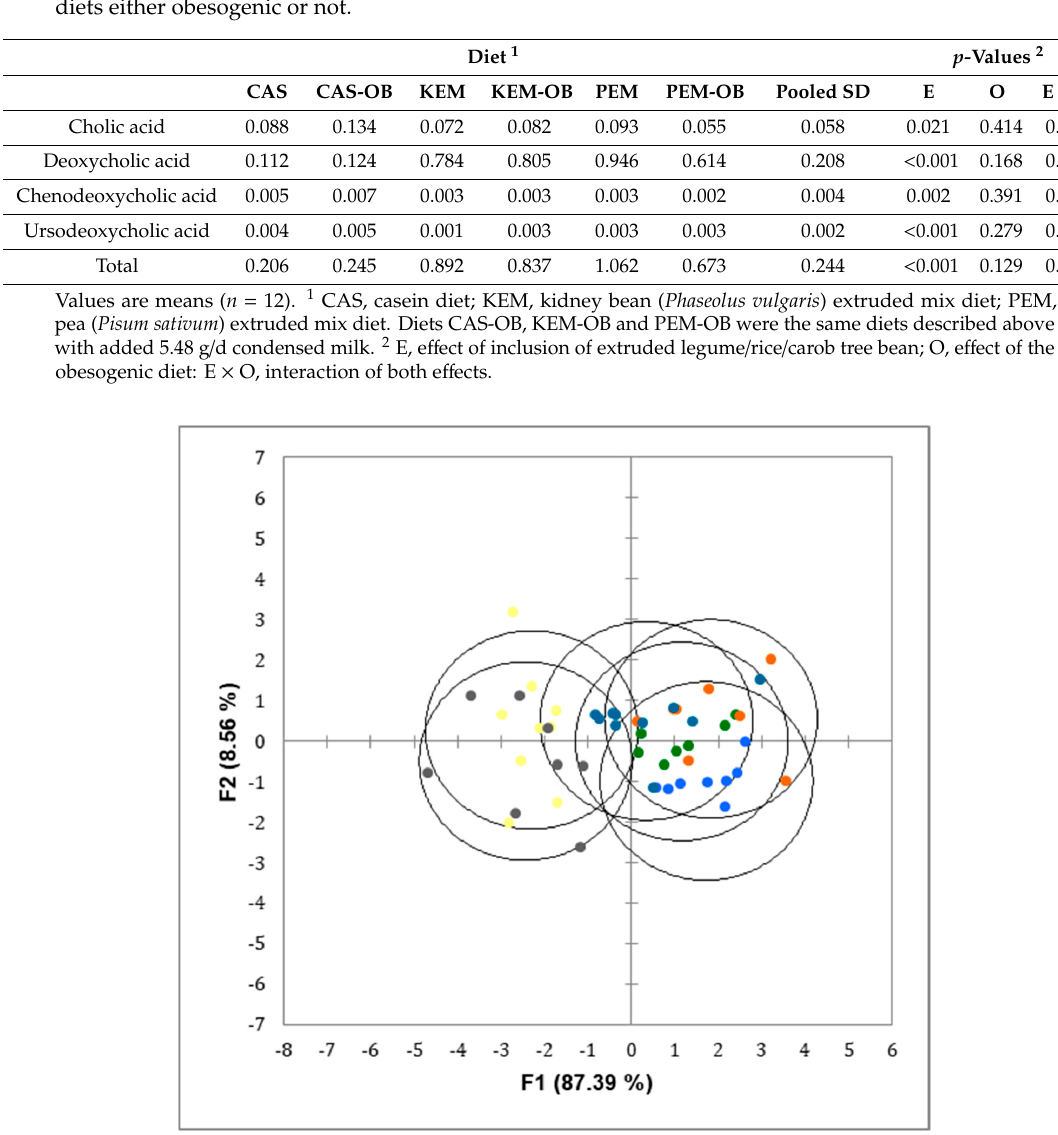
Figure 2. Discriminant analysis of the expression levels of bile acid concentration ( µ M / g) in the faeces of rats fed CAS (yellow); CAS-OB (grey); KEM (orange); KEM-OB (dark blue); PEM (light blue); PEM-OB (green). For details on the diets, see the Materials and Methods section and Table 2. Values for rats fed diets based on casein (CAS and CAS-OB) were di ff erent ( p < 0.05) from those fed diets based on extruded mixes, although not di ff erent to each